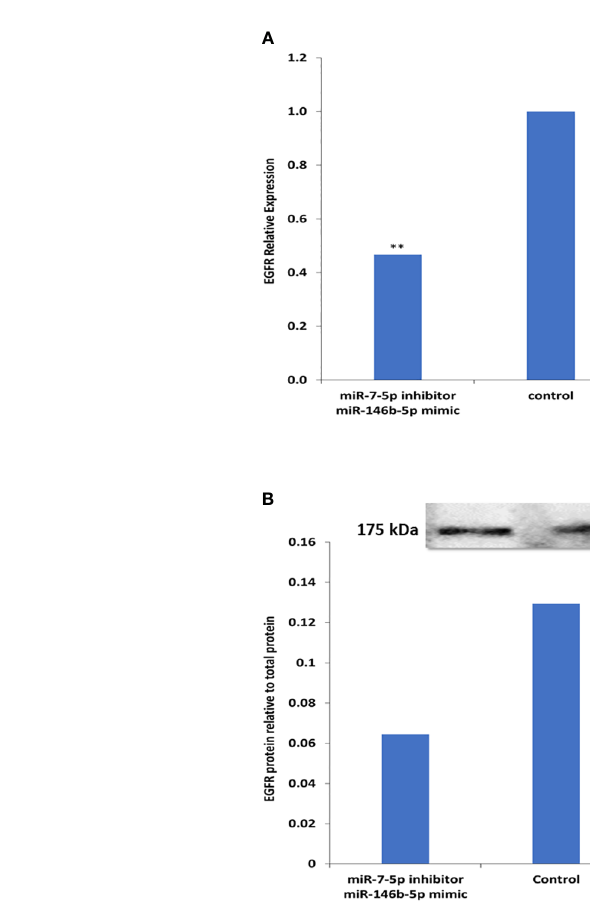
FIGURE 6 Possible factors contributing to reduced EGFR expression in thyroid cultured cells. (A) Expression of EGFR was tested by Real time PCR in fi ve different FND samples. Cells treated with miR-7-5p inhibitor and miR-146b-5p mimic show signi fi cant downregulation of EGFR (**p=0.005). Oxidative stress combined with miR-7-5p downregulation and miR-146b-5p upregulation resulted in the highest reduction of EGFR expression (***p < 0.001). (B) EGFR protein expression in the same conditions was tested by western blot and showed similar